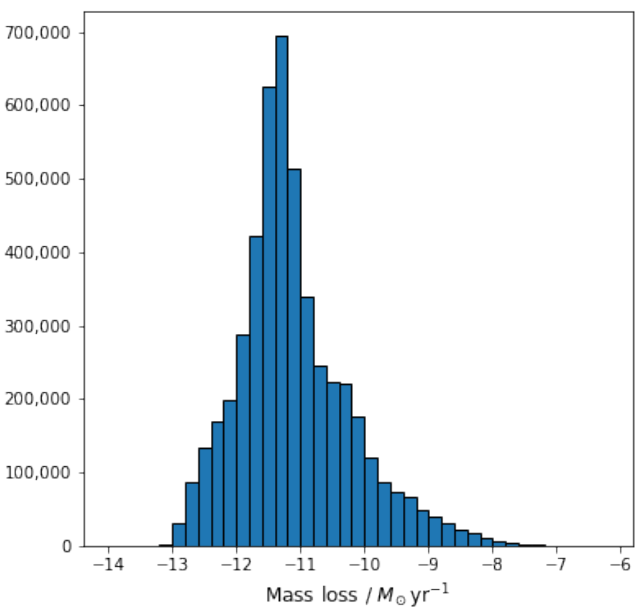
Figure 2. Mass-loss rates of our sample OB